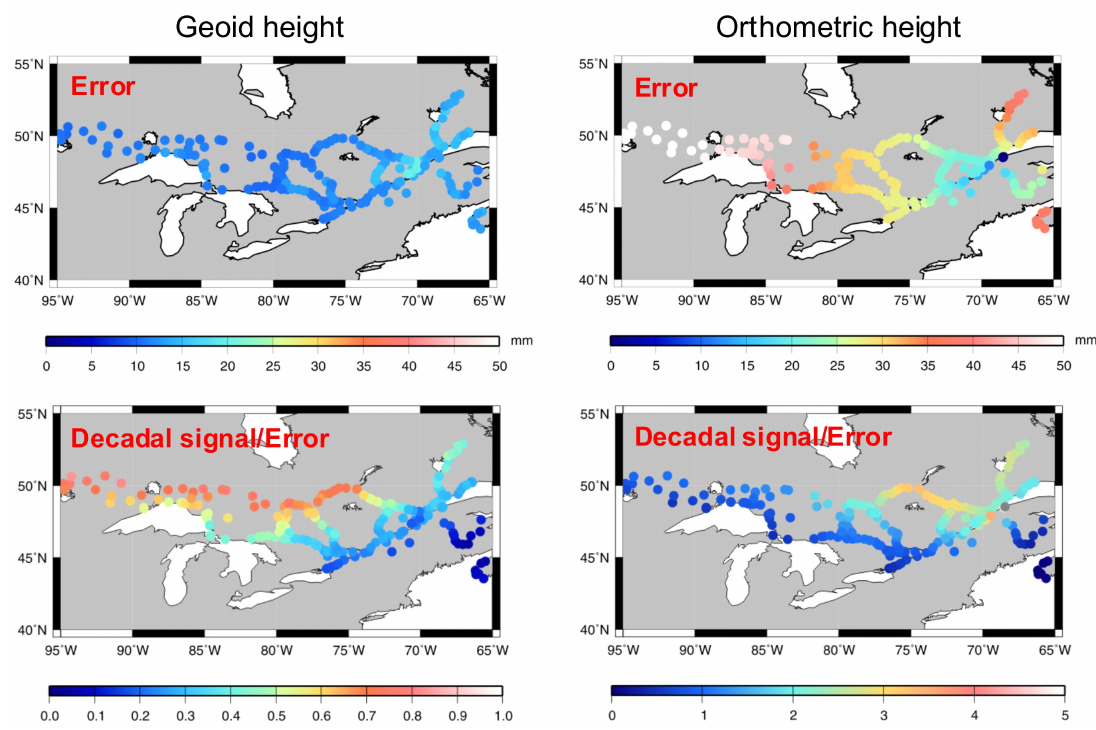
Figure 7. Upperplots: calibratedstandarddeviationsofthegeoidandorthometricheights; unitismm. Lowerplots: ratiosofthedecadalpostglacial rebound signal and the standard deviations for the geoid and orthometric heights.